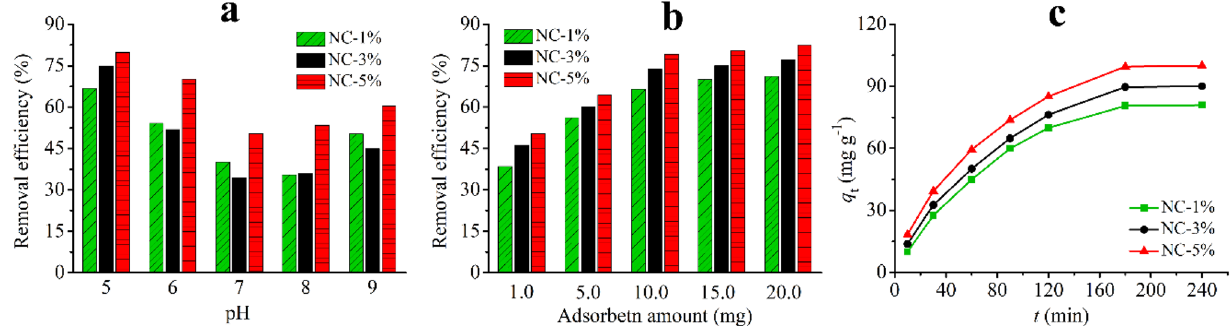
Figure 6. The effect of solution pH ( a ), adsorbent amount ( b ), and stirring time ( c ) on the adsorption of CR by the prepared